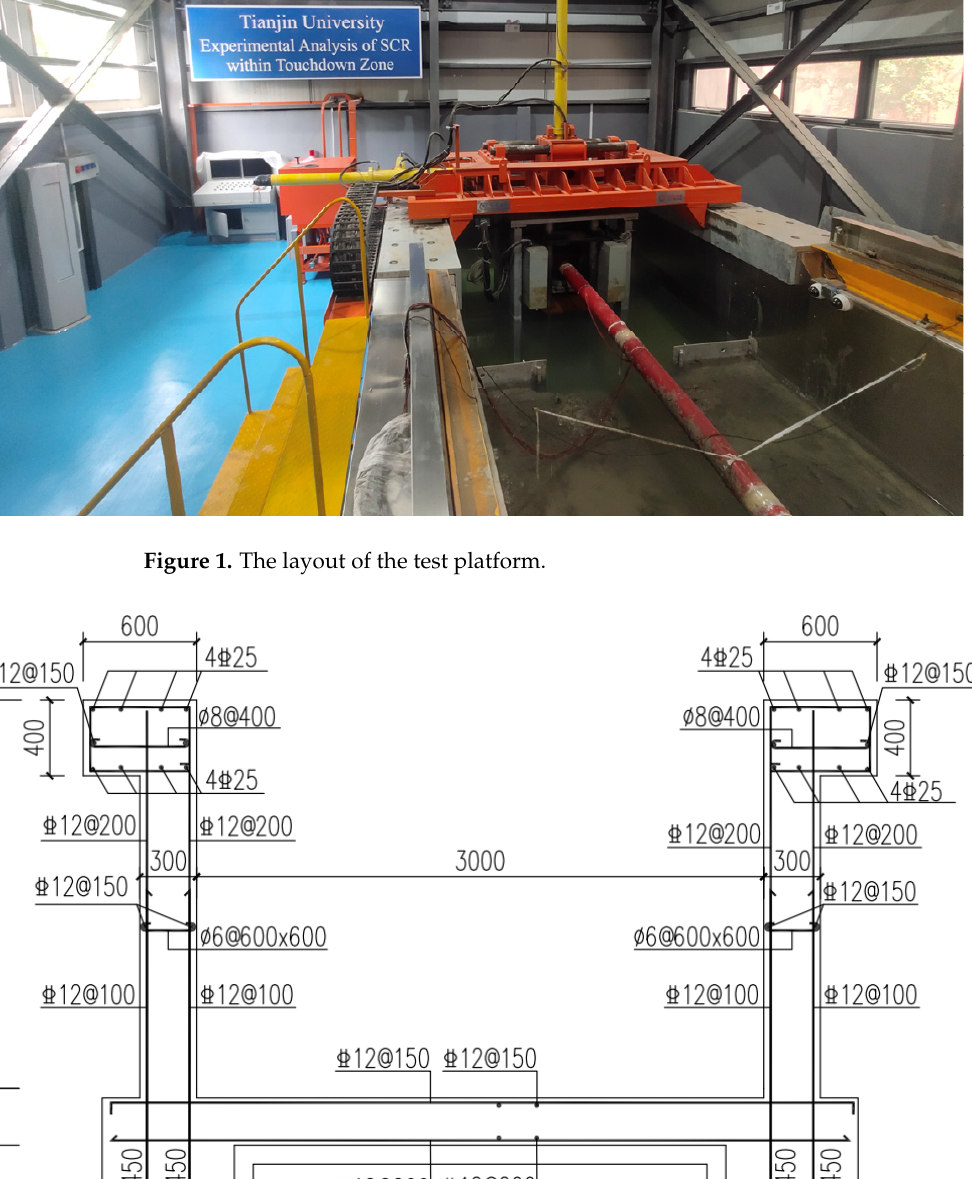
Figure 1. The layout of the test platform.